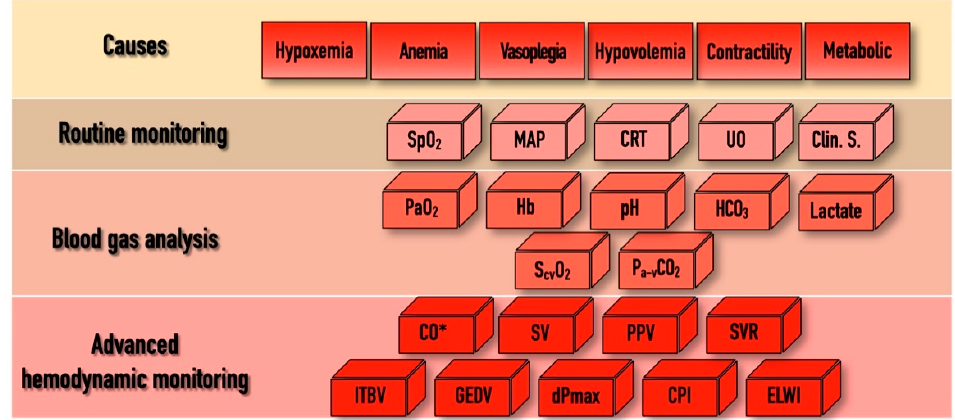
Figure 1. The “bricks” of individualized hemodynamic management. SpO 2 , pulse oximetry driven oxygen saturation; MAP, mean arterial pressure; CRT, capillary refill time; UO, urine output; Clin. S, clinical signs; PaO 2, partial pressure of oxygen; Hb, hemoglobin; HCO 3, bicarbonate; S cv O 2 , central venous oxygen saturation; P a-v CO 2 , arterial-to-venous carbon dioxide gap; CO, cardiac output; SV, stroke volume; PPV, pulse pressure variability; SVR, systemic vascular resistance; ITBV, intrathoracic blood volume; GEDV, global end-diastolic volume; dPmax, left ventricle contractility index; CPI, cardiac power index; ELWI, extravascular lung water index; * indicates that CO can be determined by invasive hemodynamic measurements or by echo-cardiography. For explanation, please see